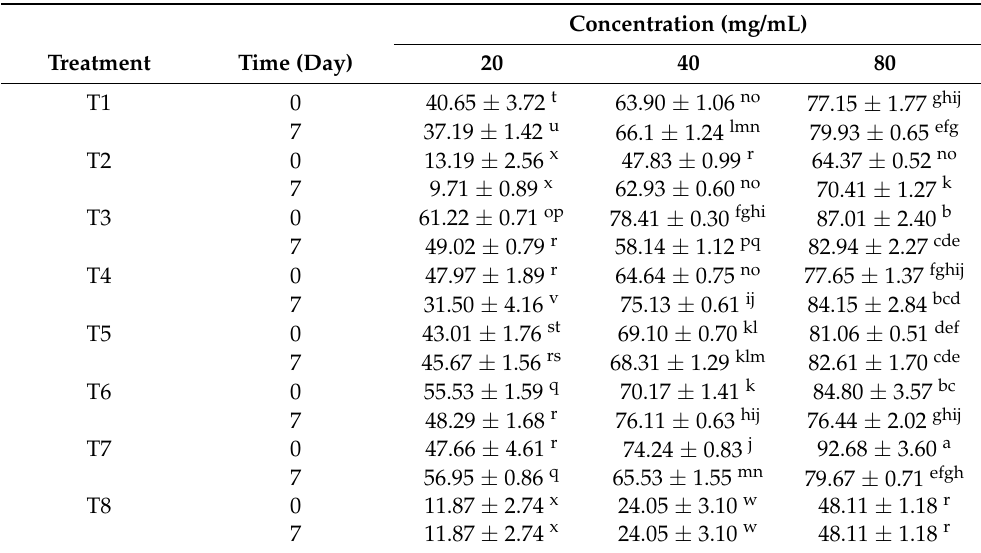
Table 1. ACE inhibitory activity of crude peptide extracts obtained from fermented milk samples at three concentrations after fermentation (day 0) and after 7 days of